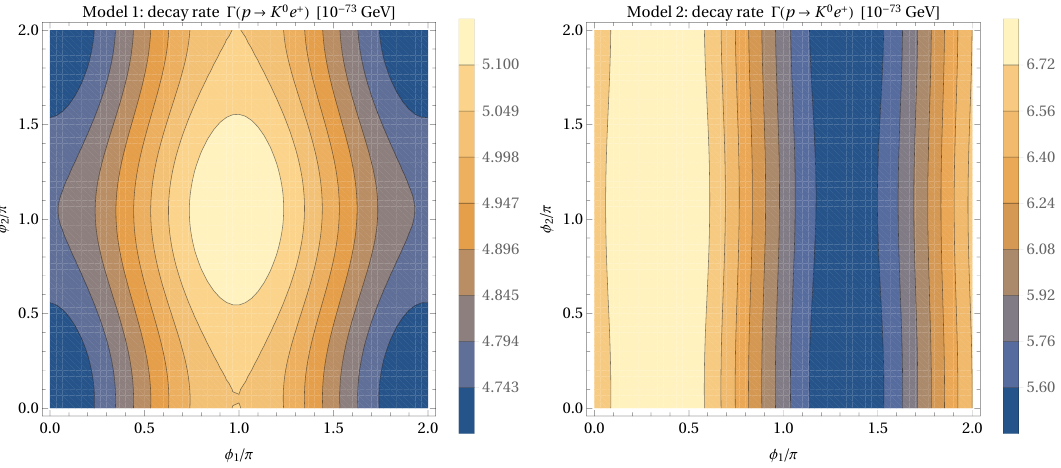
Figure 2 . Contour plots for the GUT phase dependence of the p → K 0 e + proton decay channel for the best-fit points of model 1 (left) and model 2 (right). We assumed M eff